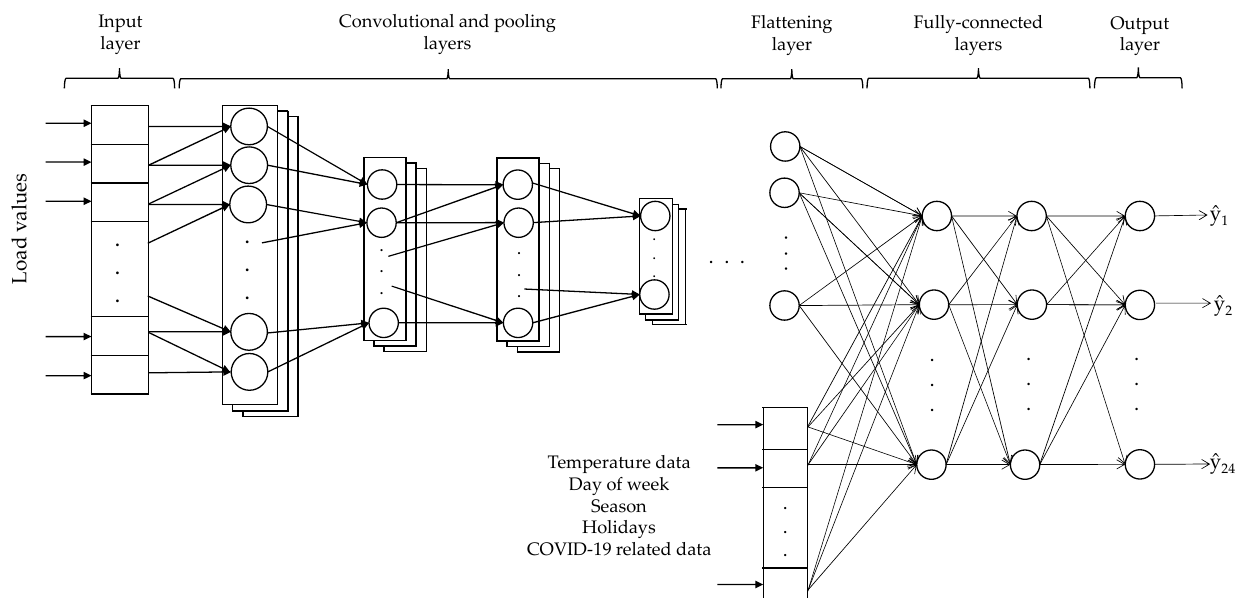
Figure 4. Architecture of the proposed Convolutional Neural Network.